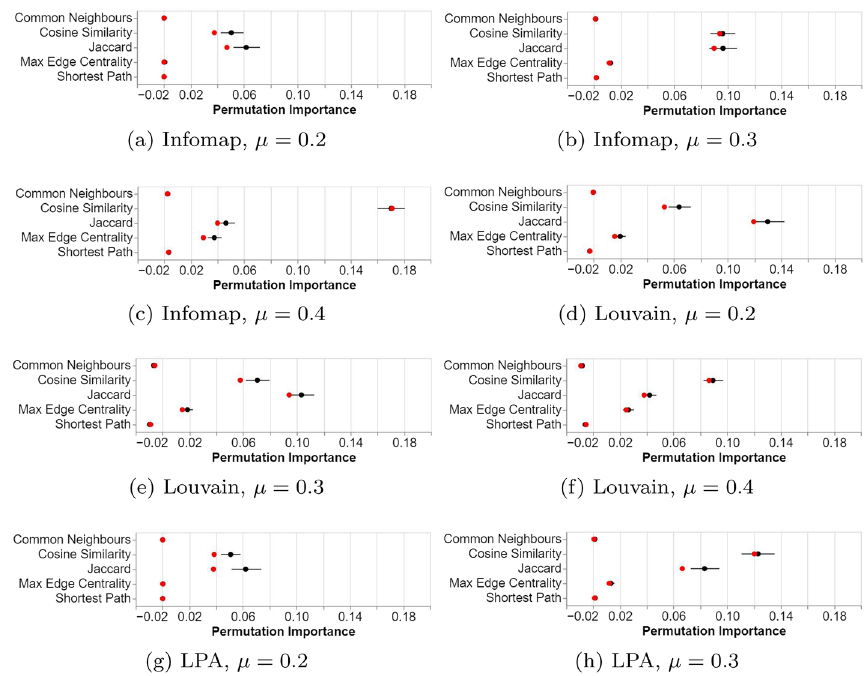
Fig. 4 Results of the pair feature experiments. Plots are of permutation importance of the metrics. Mean indicated as a black dot and median as a red dot. Lines indicate 95% bootstrapped confidence